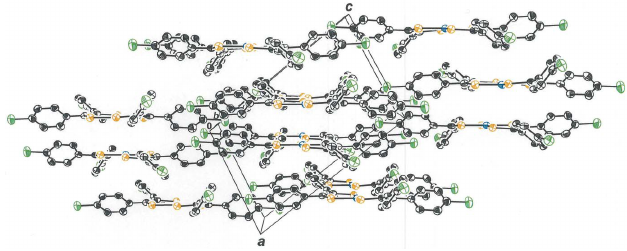
Figure 5 Packing diagram for bis[1,2-bis(4-chlorophenyl)ethylene-1,2-dithiol- ato(1 (cid:5) )]nickel(II) showing the parallel arrangement of molecules in the direction of the ac face diagonal. Displacement ellipsoids are depicted at the 50% probability